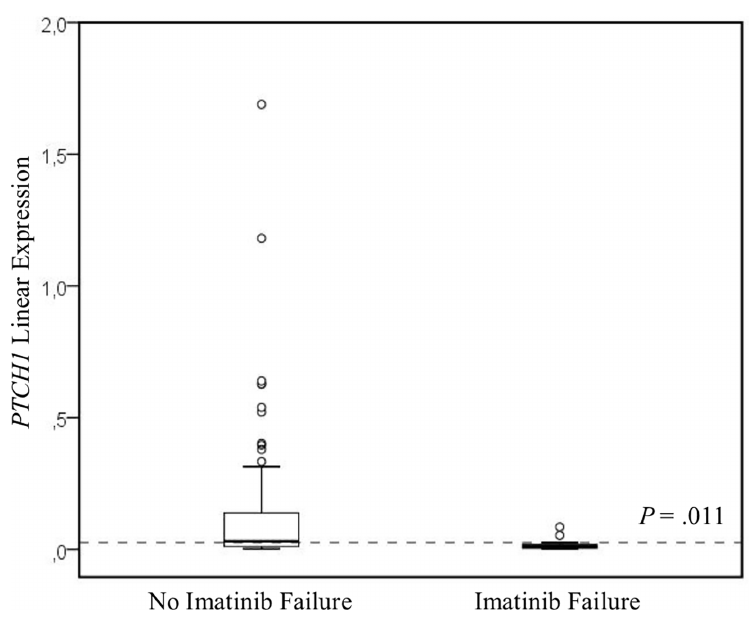
Fig 2. PTCH1 expression in patients with and without imatinib failure (IF). The dashed line indicatesthe PTCH1 expressionthreshold. IF group, n = 14; no-IF group, n = 87. Comparisonswere performed with the Mann-Whitney